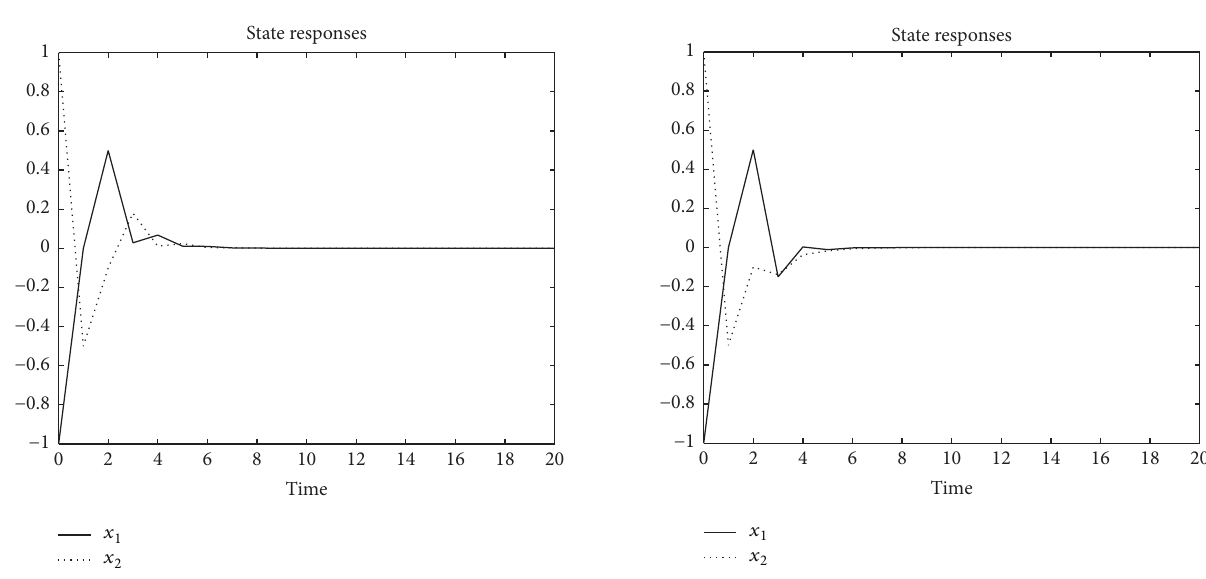
Figure 1: State trajectories of the open-loop system. Figure 2: State trajectories of the closed-loop system.